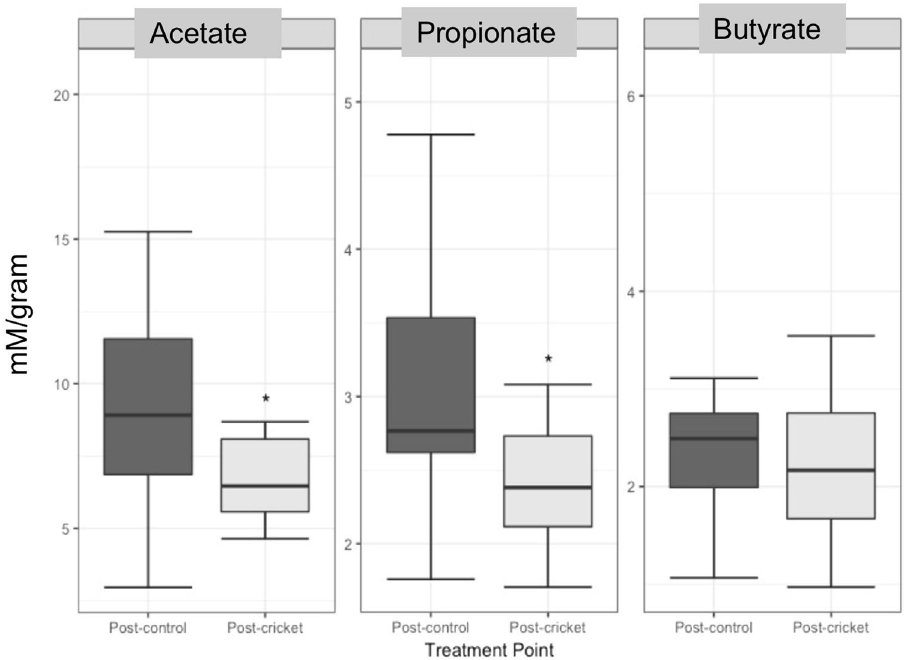
Figure 3. Boxplots of Average Excreted SCFAs across Treatment Periods